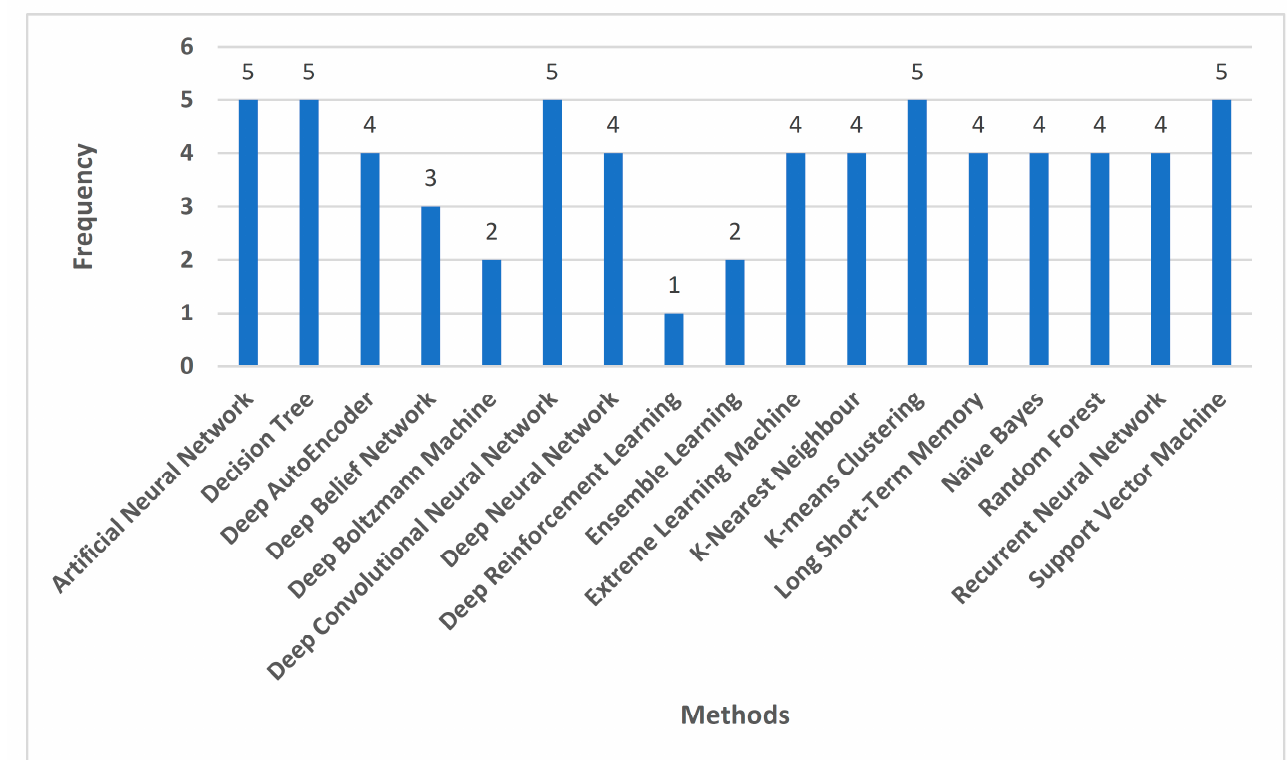
Figure 3. ML and DL methods versus frequency of papers used in this work.